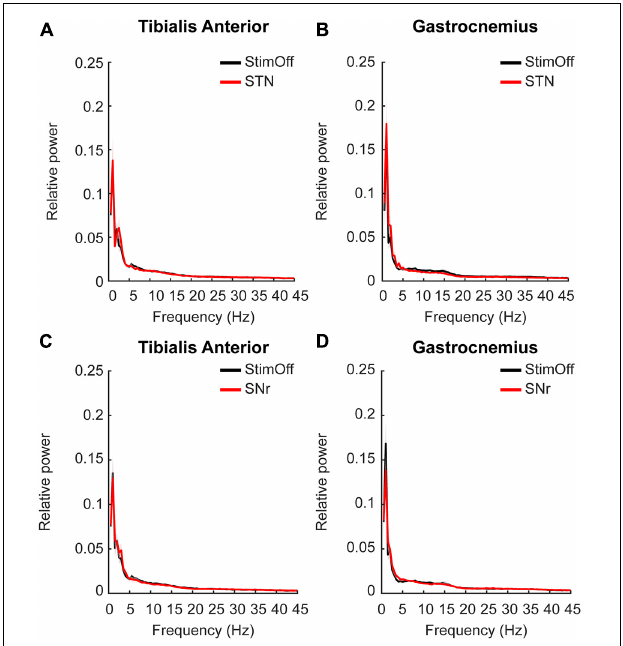
FIGURE 3 | (A,B) Power spectrum and SEM of TA (upper left panel) and GA (upper right panel) during ‘regular gait’ in PD patients with ‘StimOff’ vs. ‘STN’. There was no significant difference in the power spectra of the two conditions. (C,D) Power spectrum of TA (lower left panel) and GA (lower right panel) during ‘regular gait’ in PD patients with ‘StimOff’ vs. ‘SNr.’ There was no significant difference in the power spectra of the two conditions.